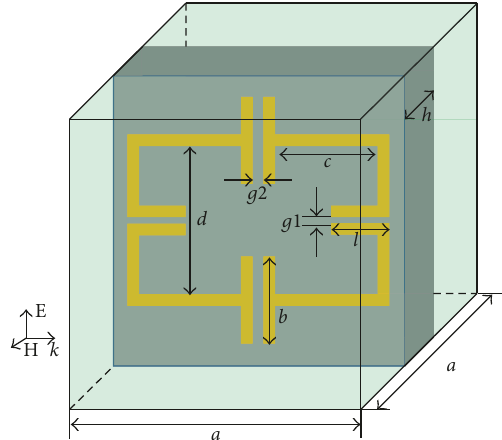
Figure 1: Geometry illustration of the proposed dual-band SNG.